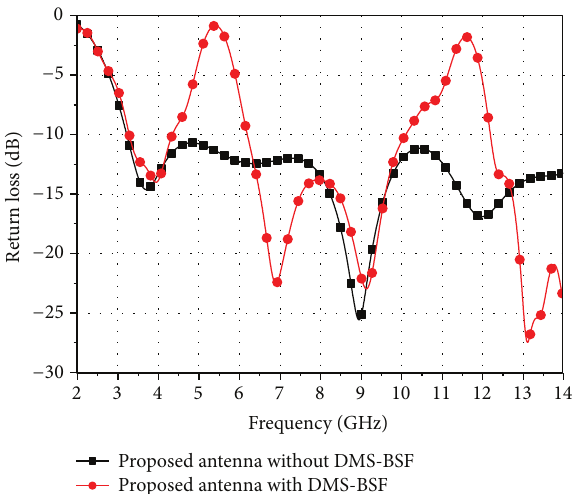
Figure 4: Return loss of CRA A with all switches OFF with/without DMS-BSF.